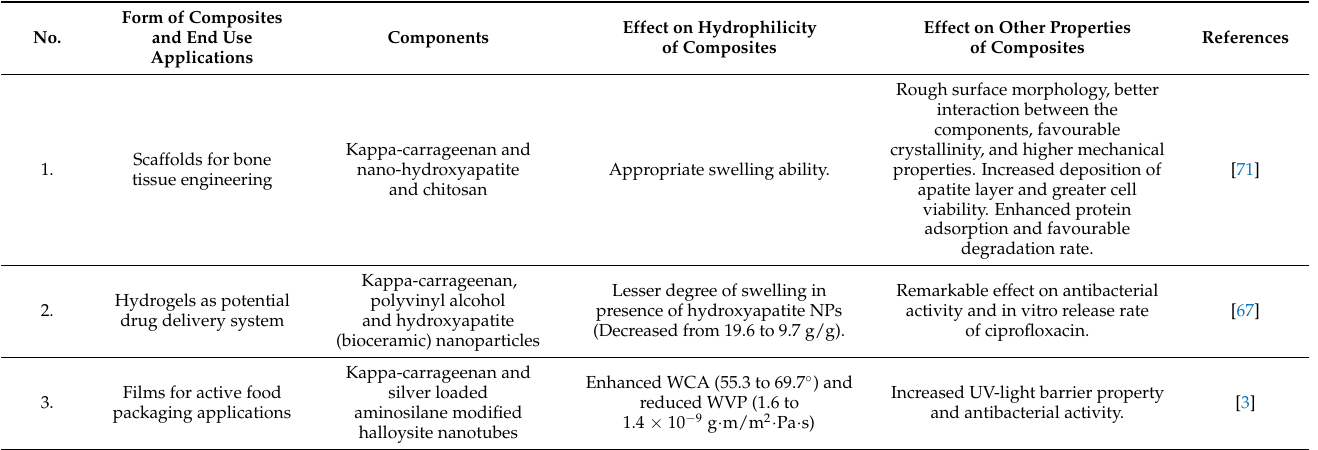
Table 8. Role of nanoclays, bioceramics, and mineral nanoparticles in the carrageenan